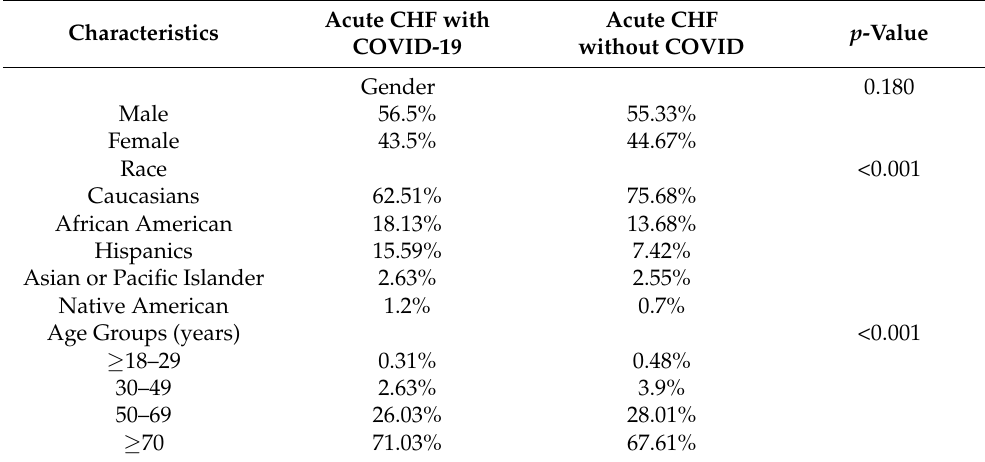
Table 3. Mortality in Acute Congestive Heart Failure (CHF) in COVID-19 Positive and Negative Patients. Characteristics